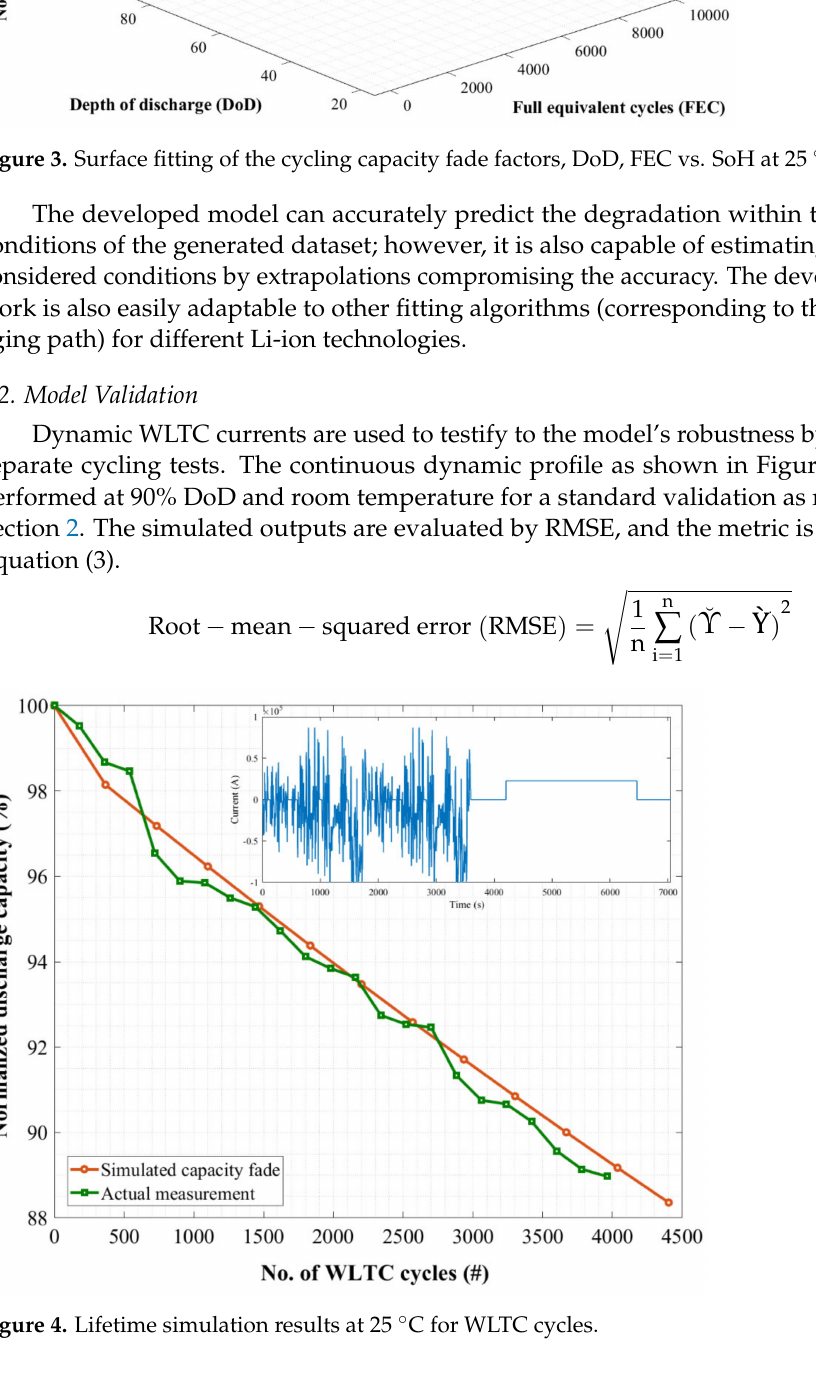
Figure 3. Surface fitting of the cycling capacity fade factors, DoD, FEC vs. SoH at 25 ◦ C.